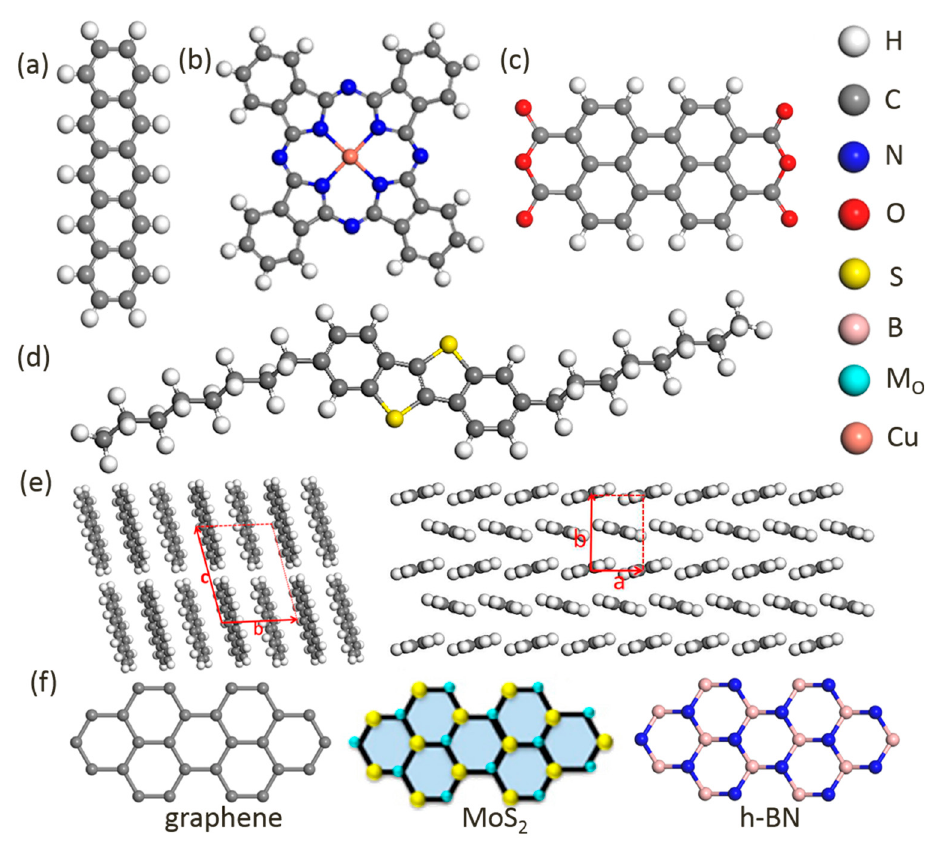
Figure 1. Molecular structures of pentacene ( a ), CuPc ( b ), PTCDA ( c ), C 8 -BTBT ( d ), respectively. ( e ) The a-b and b-c planes of a pentacene single crystal, showing the anisotropy of small organic molecules. ( f ) Schematics of three layered substrates, G, MoS 2 and h -BN.